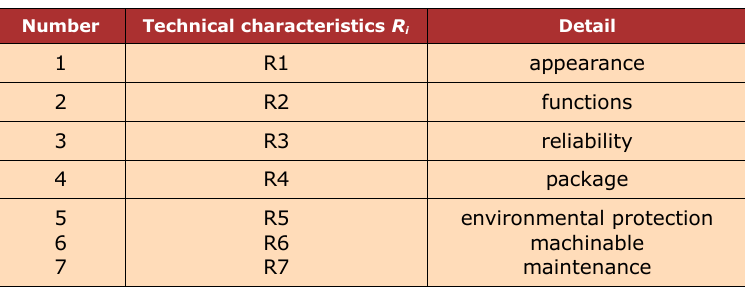
Table 3. Technical